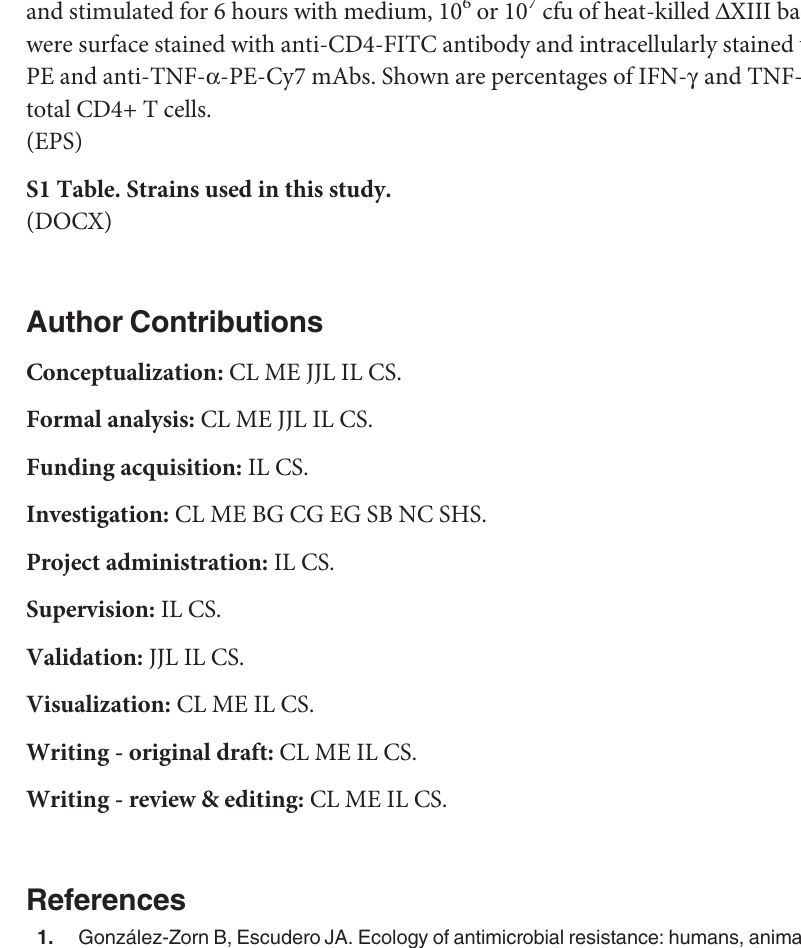
S1 Fig. Representative IFN- γ and TNF- α /CD4 staining for Δ XIII stimulated splenocytes. 28 days after immunization, splenocytes from control and Δ XIII immunized mice were plated and stimulated for 6 hours with medium, 10 6 or 10 7 cfu of heat-killed Δ XIII bacteria. Cells were surface stained with anti-CD4-FITC antibody and intracellularly stained with anti IFN- γ - PE and anti-TNF- α -PE-Cy7 mAbs. Shown are percentages of IFN- γ and TNF- α cells out of total CD4+ T cells. S1 Table. Strains used in this